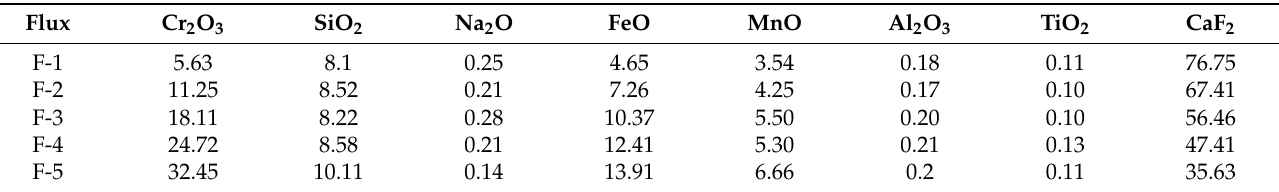
Table 3. Measured compositions of slags (wt.%).